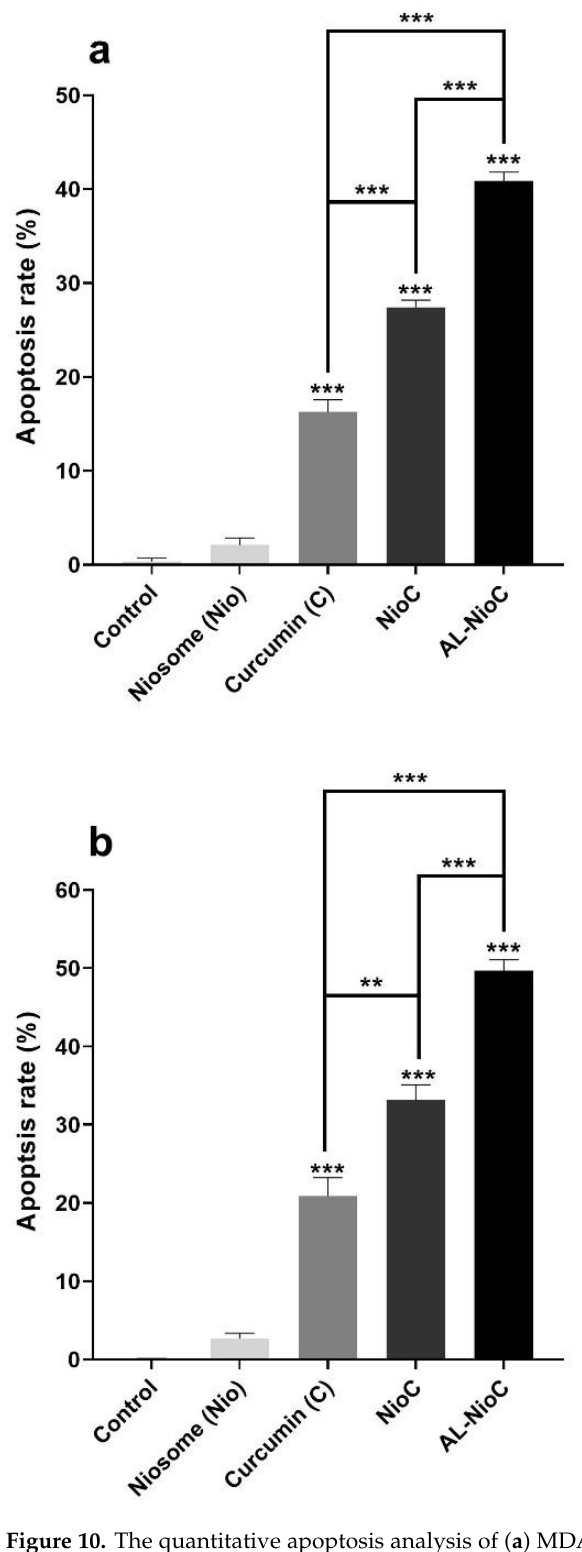
Figure 10. The quantitative apoptosis analysis of ( a ) MDA-MB-231 cells and ( b ) SKBR3 cells after treatment with different samples; (** p < 0.01, and *** p < 0.001).